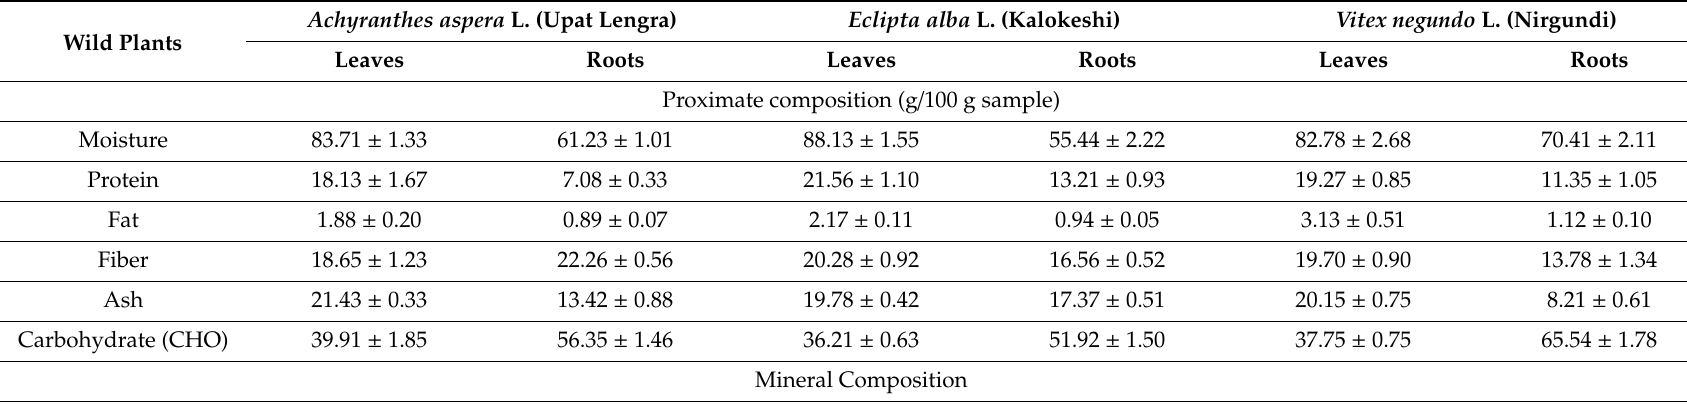
Table 1. Proximate composition (g / 100g dry weight (DW)), and macro minerals and micro minerals (DW basis) of selected wild plants. Wild